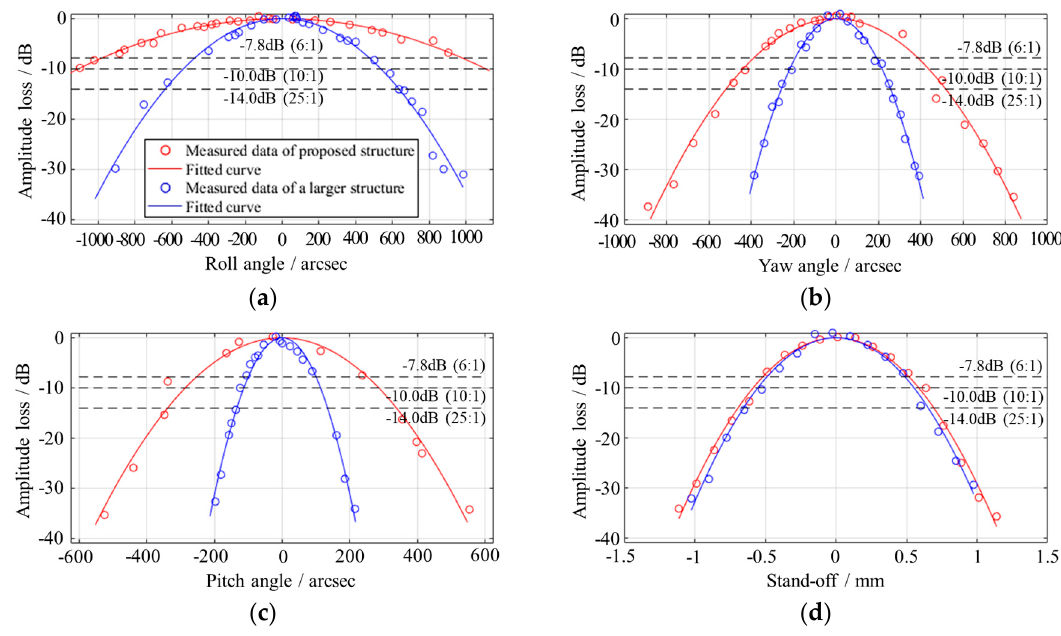
Figure 10. Experimental curves showing the relationships between the misalignment errors and amplitude loss of the interfering signal. ( a ) Roll angle. ( b ) Yaw angle. ( c ) Pitch angle. ( d ) Stand-off error. All four figures share the same legend as the first figure.